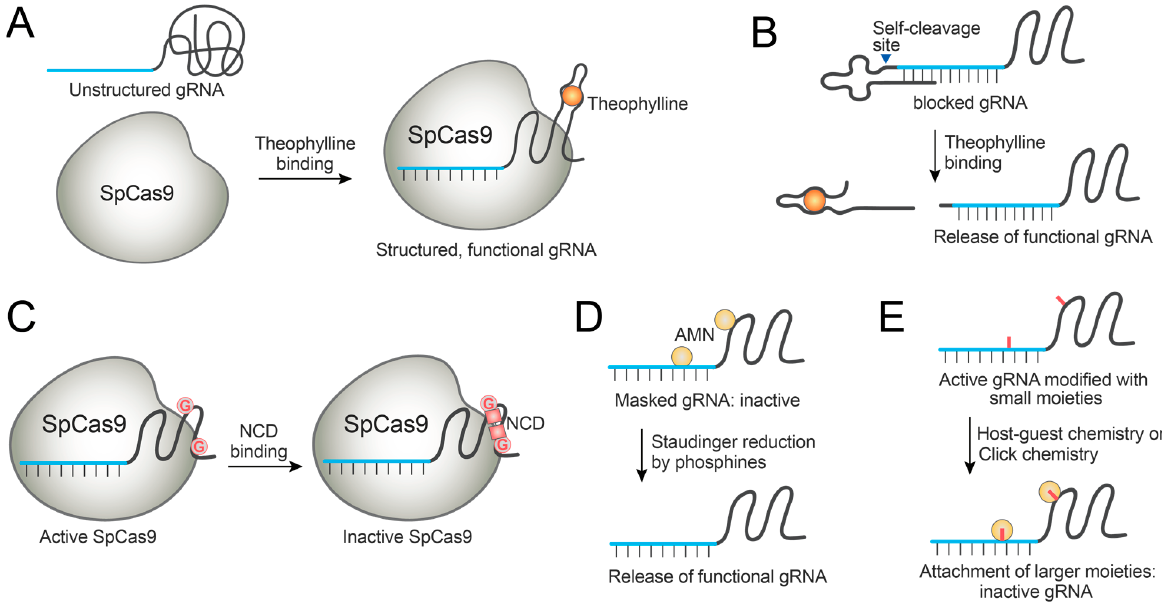
Figure 5. Examples of small-molecule control of engineered gRNAs. ( A ) gRNAs are fused with an aptamer that is unstructured, but are stabilized and folded into a functional form by binding to theophylline. ( B ) gRNAs are fused with an aptazyme that is activated by binding to theophylline and induces the RNA self-cleavage to release functional gRNAs. ( C ) Mutant gRNAs containing G-G mismatches are recognized and inactivated by NCD. ( D ) A gRNA masked with AMN groups becomes activated by reacting with phosphines. ( E ) Active gRNAs that contain small chemical modifications become inactive by the binding or reaction with larger moieties.